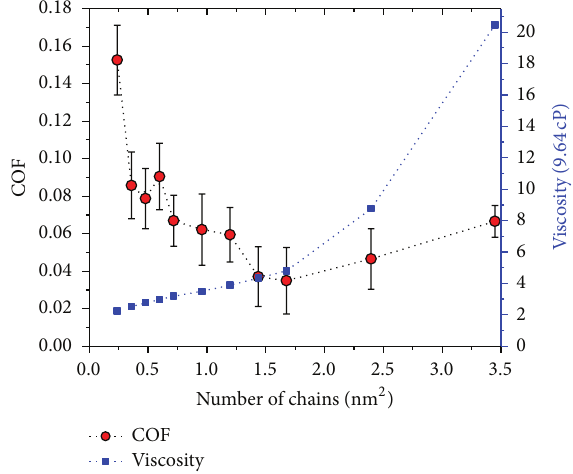
Figure 10: The coefficient of friction (COF, filled circles) and the viscosity (filled squares) of a fluid made up of two opposing polymer brushes with degree of polymerization equal to 7 beads, immersed in a solvent, as functions of the grafting density of polymer chains. The error bars for the viscosity are smaller than the symbols’ size. Dotted lines are only guides for the